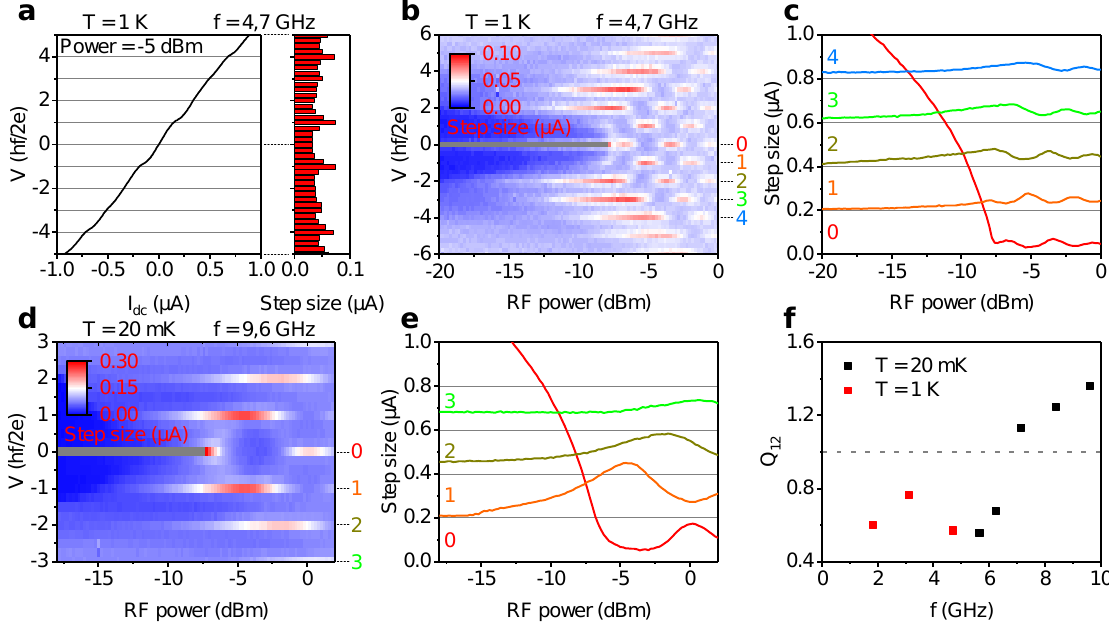
Figure 2. Radio frequency response of junction 1a. All data in this figure were obtained by sweeping from negative to positive bias voltage. ( a ) IV -curve under radio frequency irradiation of junction 1a in the left hand graph. The right side graph shows the voltage binning data from the IV -curve on the left. ( b ) Voltage binning data for a range of irradiation powers at 4.7 GHz of junction 1a at 1 K. The first Shapiro step is clearly absent. The scale has been adjusted to clarify the features; gray indicates the data-point falls above the scale. ( c ) Integer Shapiro step size for a range of radio frequency powers at 4.7 GHz of junction 1a. Subsequent curves have been shifted by 0.2 µ A for clarity. ( d ) Voltage binning data for a range of radio frequency powers at 9.6 GHz of junction 1a. The first Shapiro step is clearly present. ( e ) Integer Shapiro step size for a range of radio frequency powers at 9.6 GHz of junction 1a. ( f ) The quotient of the first and second Shapiro steps, Q 12 , of junction 1a for several